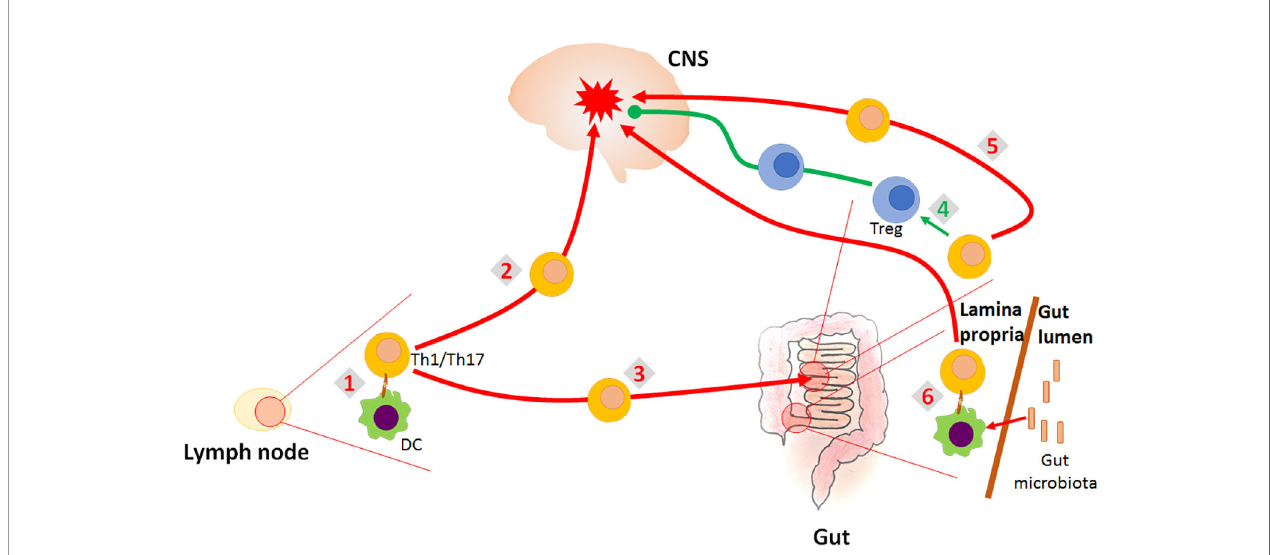
FIGURE 1 | Role of the gut in the CNS autoimmunity. CNS-autoreactive Th1 and Th17 cells are activated in the lymph nodes (1). They migrate into the CNS where they initiate in fl ammatory response imposing destruction of the CNS tissue (2). They also migrate into the gut (3), where they can be re-differentiated to Treg which counteract the in fl ammation in the CNS (4). However, they can also be supported by the gut environment in their encephalitogenicity (5). Finally, it is proposed that encephalitogenic Th cells might be initially activated in the gut by the process of molecular mimicry, as they cross-react with gut microbial antigens